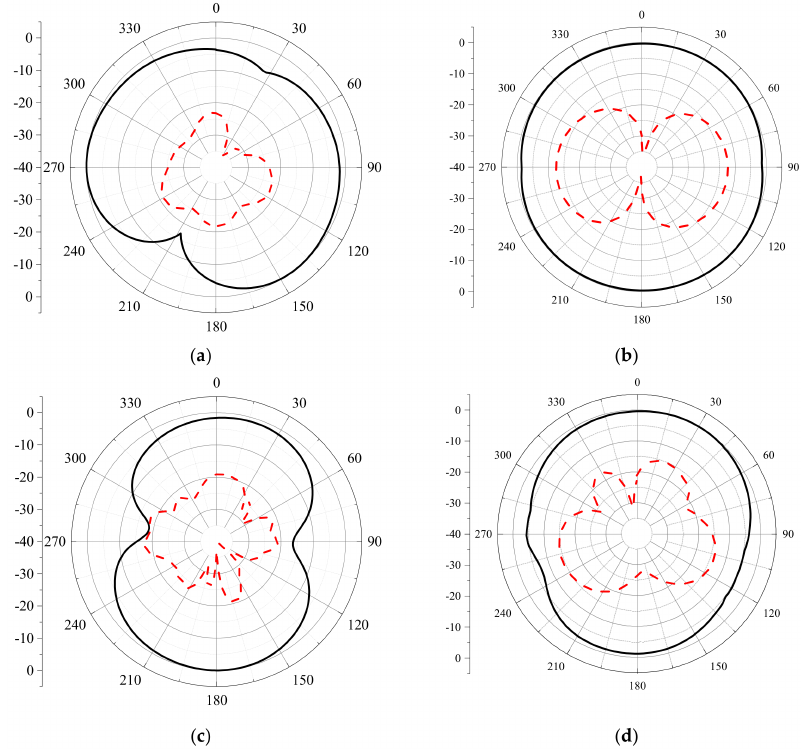
Figure 8. Radiation shapes of the fabricated antenna: ( a ) E-plane at 2.45 GHz, ( b ) H-plane at 2.45 GHz, ( c ) E-plane at 5.5 GHz, and ( d ) H-plane at 5.5